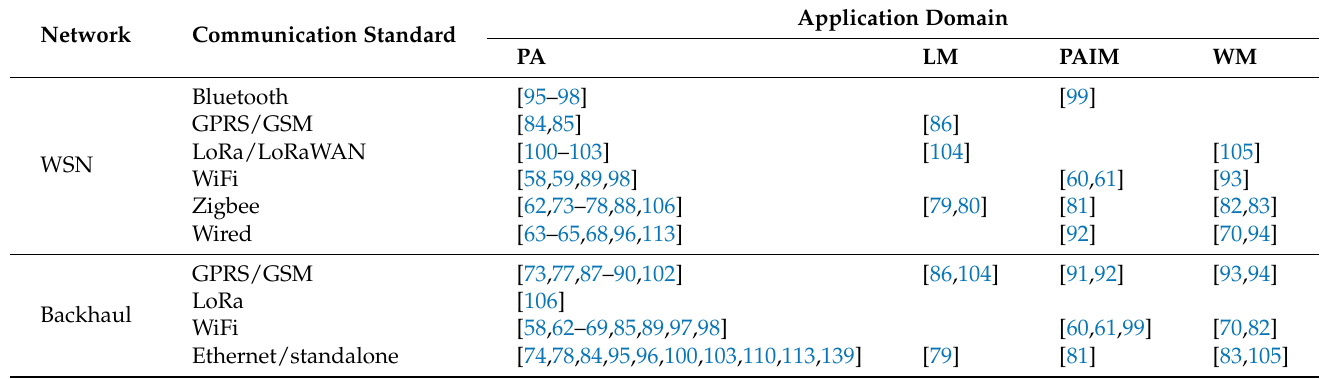
Table 5. WSN and backend communication standards adopted in smallholder agriculture applications (PA:Precision Agriculture, LM: Livestock Management, WM: Weather Monitoring, PAIM: Pest and Animal Infestation